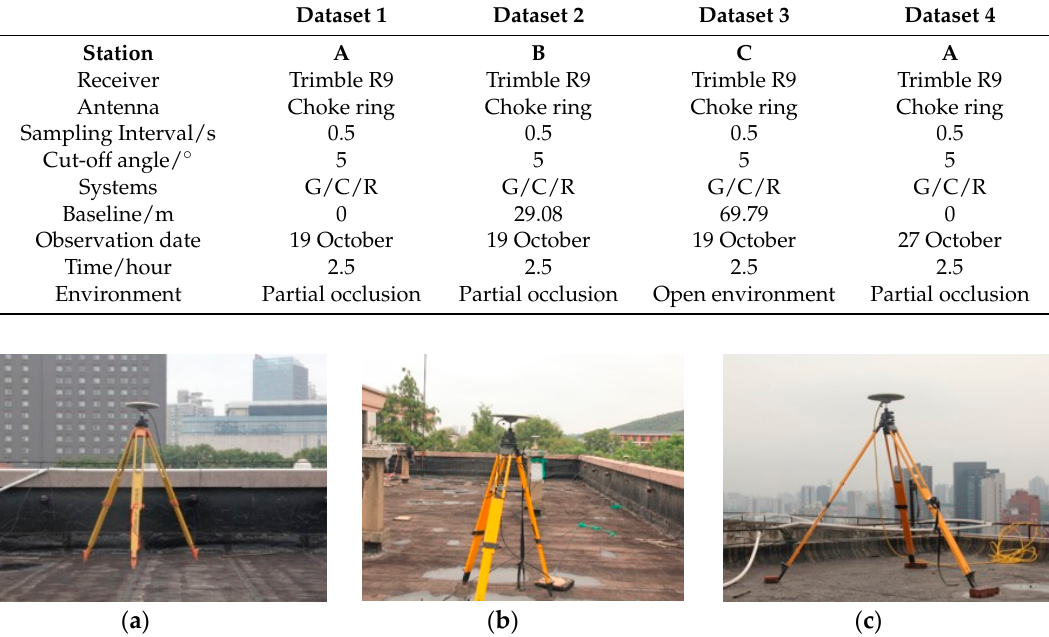
Figure 4. Observation environment and GNSS antennas used in the experiments. ( a ) Station A, ( b ) Station B, ( c ) Station C.